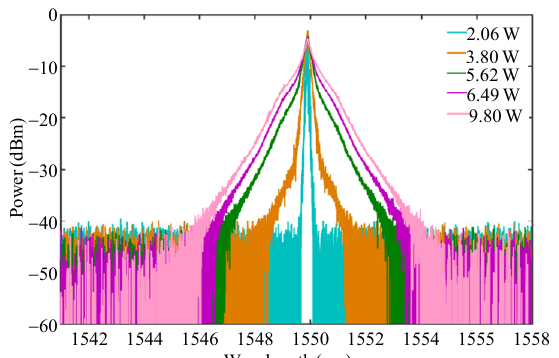
Fig. 3 Measured lasing spectral evolution with different pump powers.